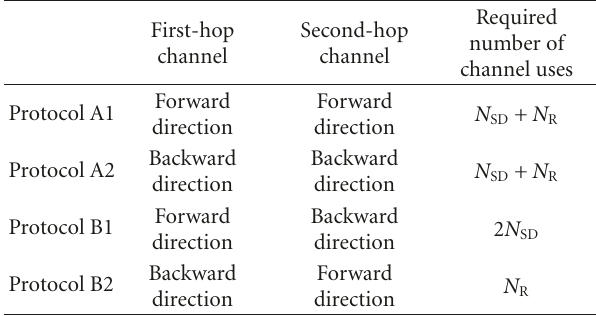
Table 1: Direction of measurement and required number of channel uses to estimate all first-hop and second-hop channel coe ffi